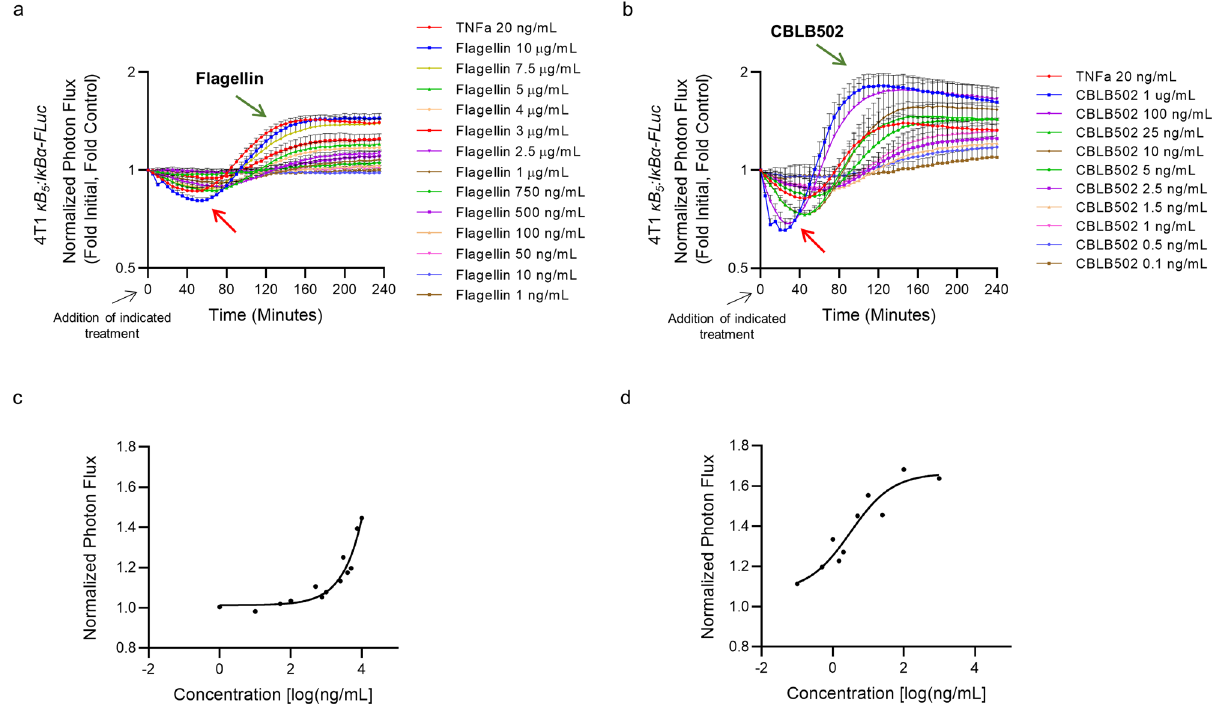
Fig. 1 Characterization in vitro of 4T1 murine mammary carcinoma cells response to incubation with TLR5 agonists. 4T1 cells stably expressing p κ B :I κ B α FLuc were stimulated with the indicated ligand at t = 0 and bioluminescence activity imaged every 5min for 4h. Data are displayed as normalized photon 5 fl ux values (average fold-initial, fold-vehicle). a 4T1 cells stably expressing p κ B 5 :I κ B α FLuc were treated with increasing fl agellin concentrations: 1ng/ml ( n = 7), 10ng/ml ( n = 2), 50ng/ml ( n = 2), 100ng/ml ( n = 7), 500ng/ml ( n = 7), 750ng/ml ( n = 2), 1 μ g/ml ( n = 7), 2.5 μ g/ml ( n = 7), 3 μ g/ml ( n = 5), 4 μ g/ml ( n = 5), 5 μ g/ml ( n = 7), 7.5 μ g/ml ( n = 5), 10 μ g/ml ( n = 7), and TNF α 20ng/ml ( n = 7). Error bars represent S.E.M. for the indicated number of independent experiments. b 4T1 cells stably expressing p κ B 5 :I κ B α FLuc were treated with increasing CBLB502 concentrations: 0.1ng/ml ( n = 3), 0.5ng/ml ( n = 3), 1ng/ml ( n = 3) 1.5ng/ml ( n = 3), 2.5ng/ml ( n = 3), 5ng/ml ( n = 3), 10ng/ml ( n = 3), 25ng/ml ( n = 3), 100ng/ml ( n = 3), 1 μ g/ml ( n = 3), and TNF α 20ng/ml ( n = 3). Error bars represent S.E.M. for the indicated number of independent experiments. c The half maximal effective concentration (EC50) of fl agellin in 4T1 cells is >10 4 ng/mL in this model. d The half maximal effective concentration (EC50) of CBLB502 in 4T1 cells is approximately 3.1ng/mL in this model. Table 1 Treatment doses and delivery routes. Treatment Initial dose and delivery site Subsequent dose and delivery site